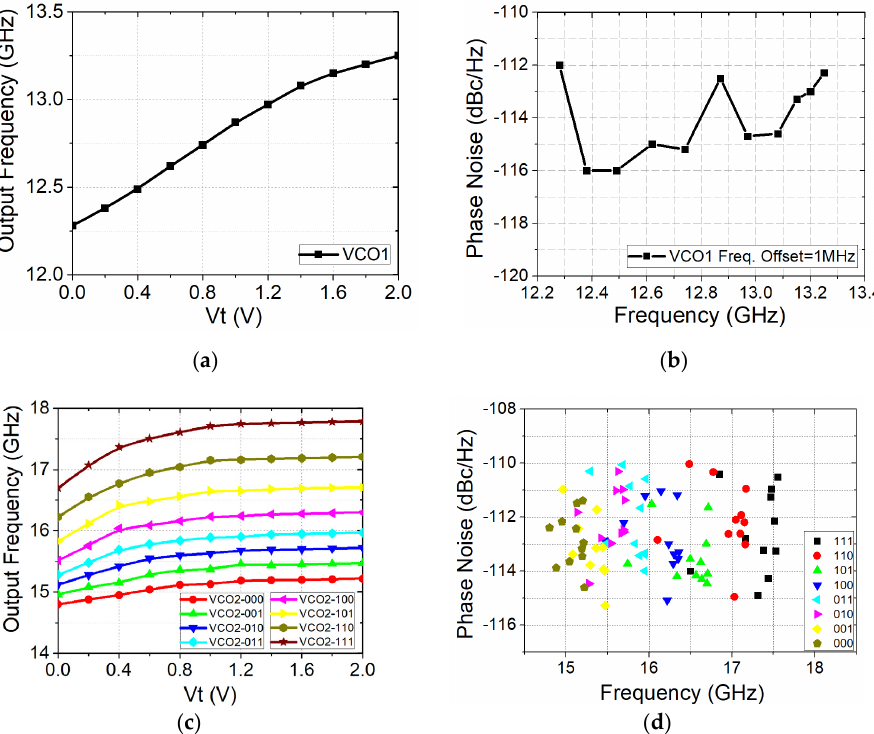
Figure 9. Measured results for ( a ) the output frequency for the Colpitts VCO1 in Loop1; ( b ) the phase noise of the VCO1 at 1 MHz offset; ( c ) the output frequency for the Colpitts VCO2 with three-bit cap bank in Loop2; ( d ) the phase noise of the VCO2 at 1 MHz offset. Figure 10a,b shows the measured phase noise of the dual-loop dual-output frequency synthesizer, which are − 79.3 dBc/Hz@10 kHz, − 88.9 dBc/Hz@100 kHz, and − 129.1 dBc/Hz@10 MHz at 12.96 GHz for Output1 and − 76.6 dBc/Hz@10 kHz, − 80.2 dBc/Hz@100 kHz, and − 117.2 dBc/Hz@10 MHz at 32.535 GHz for Output2. The two outputs of the fre- quency synthesizer can support the channel centered at 45.495 GHz for IEEE 802.11aj (45 GHz) in a super-heterodyne transceiver, as shown in Figure 2b. By configuring a series of division ratios (N = 29, 31, 33, …, 57, 64, 66, 68) for MMD in Loop2, all the 540/1080 MHz channels of IEEE802.11aj (45 GHz) can be supported. The loop bandwidth of the two loops is designed as ~50 kHz and ~450 kHz, respectively, to optimize the in-band/out-of-band phase noise and spur attenuation. Compared to the simulated phase noise performance in Figure 7, the measured loop bandwidths shrink 50~100 kHz for Loop1 and Loop2, pos- sibly due to some parasitic capacitance in the loop, and the measured phase noise de- grades 2~5 dB for in-band and out-of-band noise, which possibly results from the 1/f noise model for the transistor provided by the process. Compared to the Loop1, there are more spurs from Output2 of the synthesizer at 1~10 MHz offset, which is probably due to the noise coupling from the cap-bank biasing and power supply network. ( a )